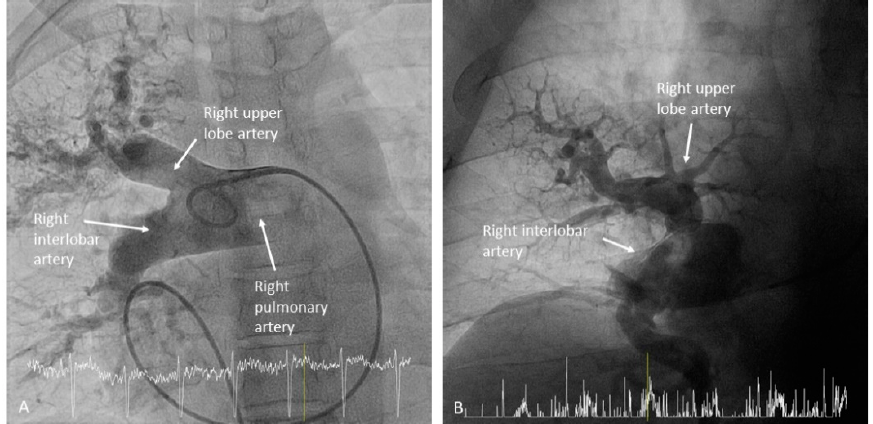
an independent origin in the interlobar artery.